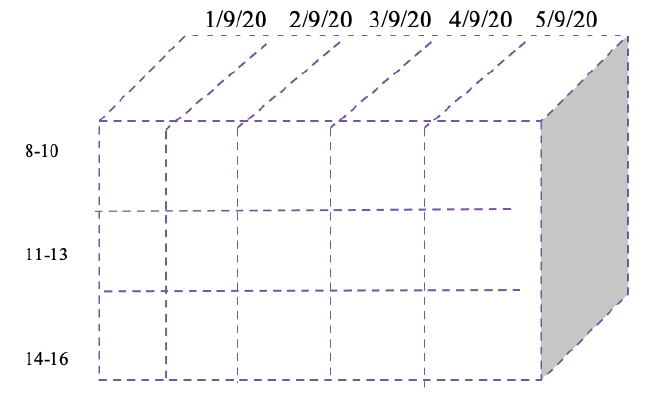
Figure 1: Representation of The Timetable